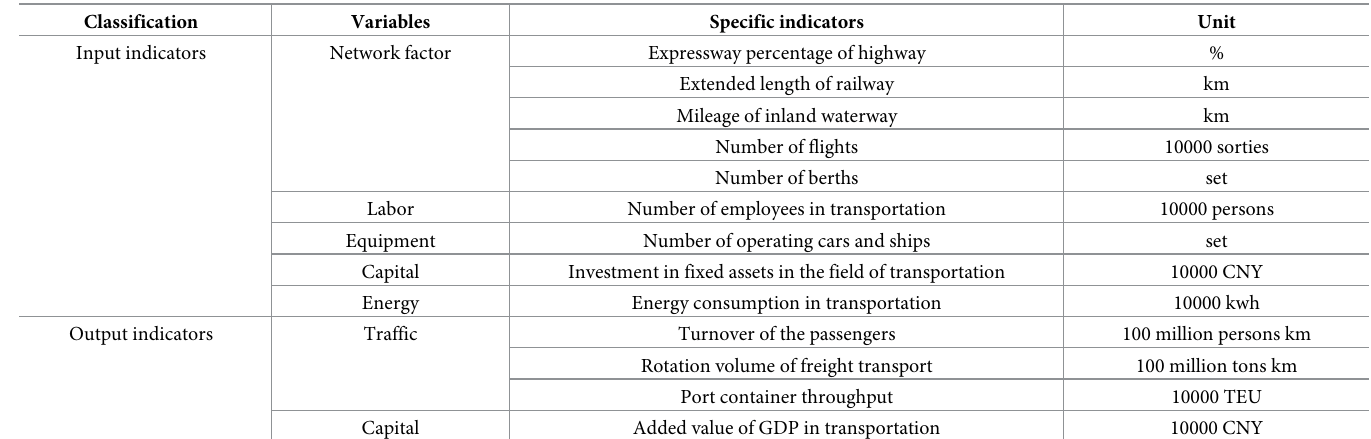
Table 2. Index system of integrated transport